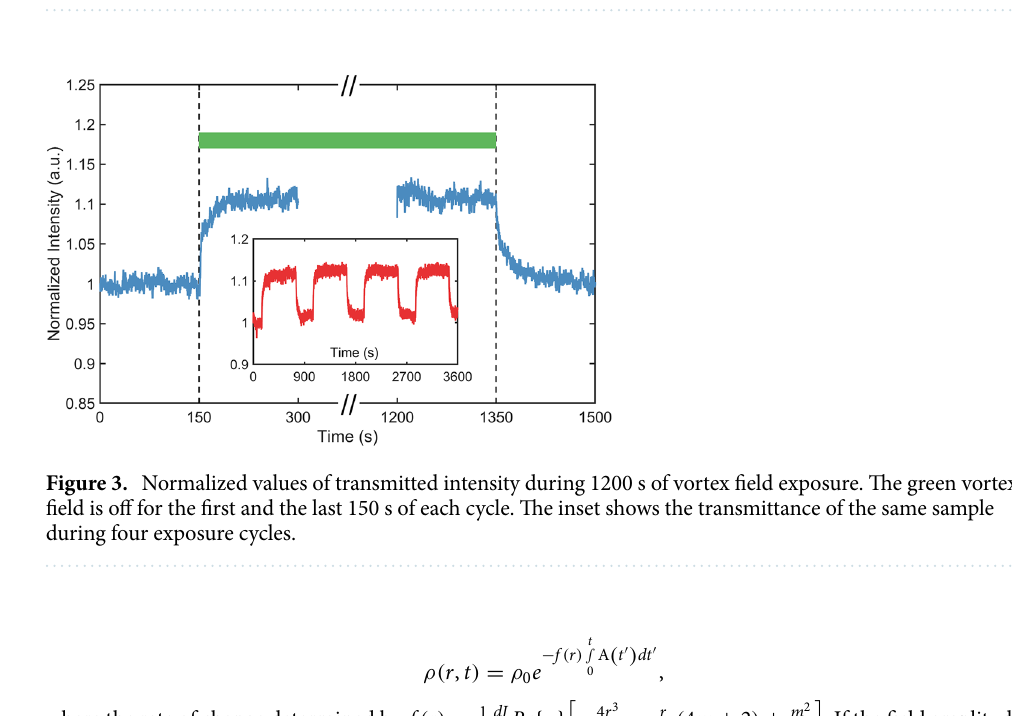
Figure 2. Schematic of experiment. An optical vortex beam with m = 2 is launched through a colloidal suspension. A coaxial Gaussian beam is used to continuously monitor the optical density.